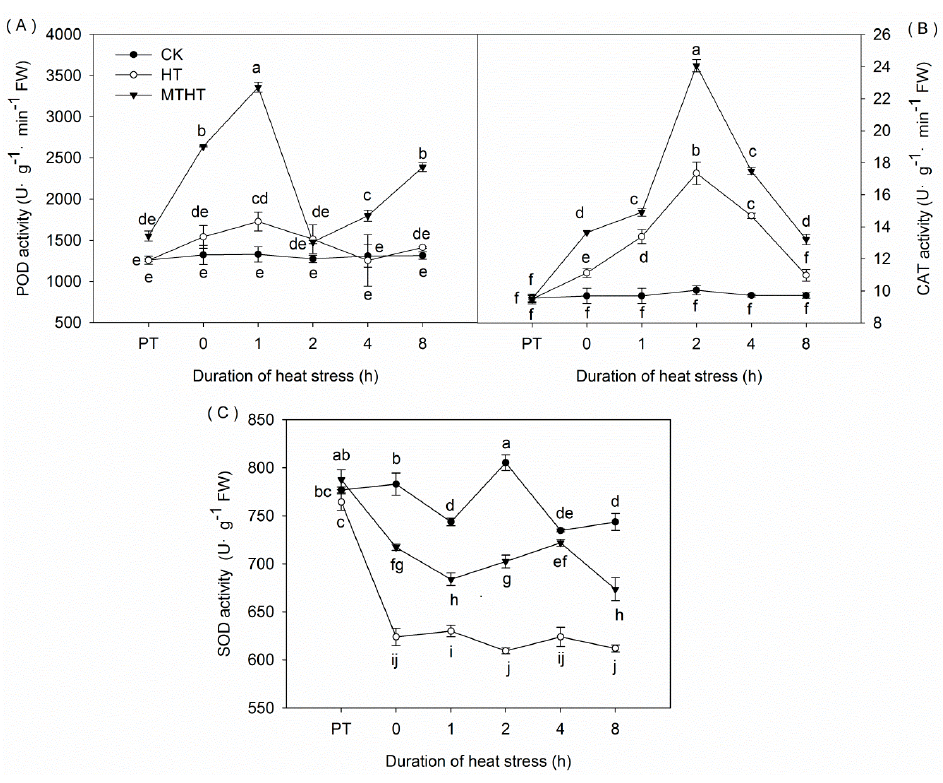
Figure 2. Antioxidant enzyme activity under heat stress. ( A ) Peroxidase (POD); ( B ) catalase (CAT); and ( C ) superoxide dismutase (SOD). Lowercase letters indicate significant differences ( p < 0.05).